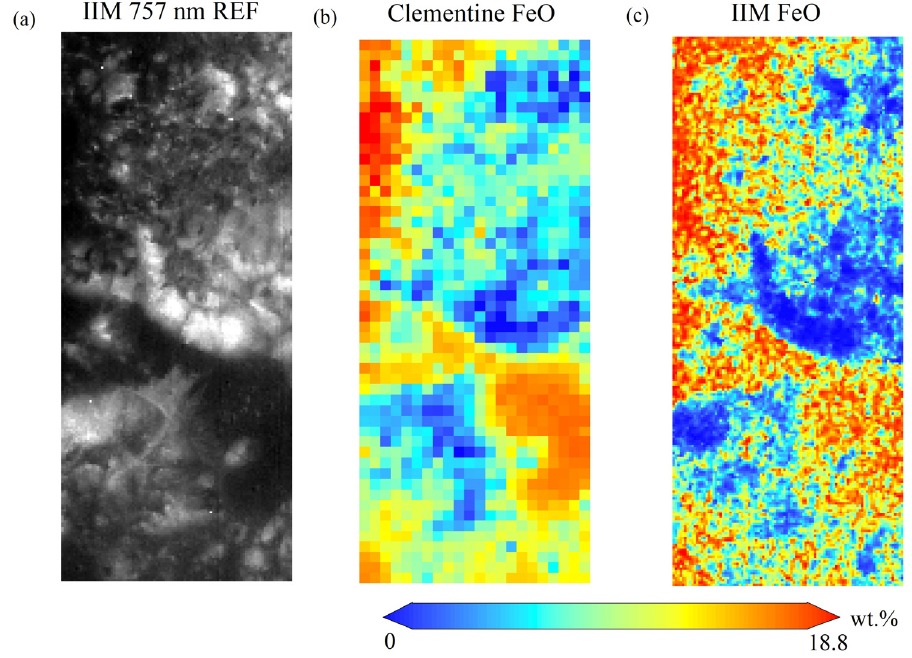
Figure 9. Apollo 17 area: ( a ) IIM 757 nm reflectance image, ( b ) FeO contents from Lucey et al. [17], and ( c ) FeO prediction results of the Extra-Trees model based on feature band selection.